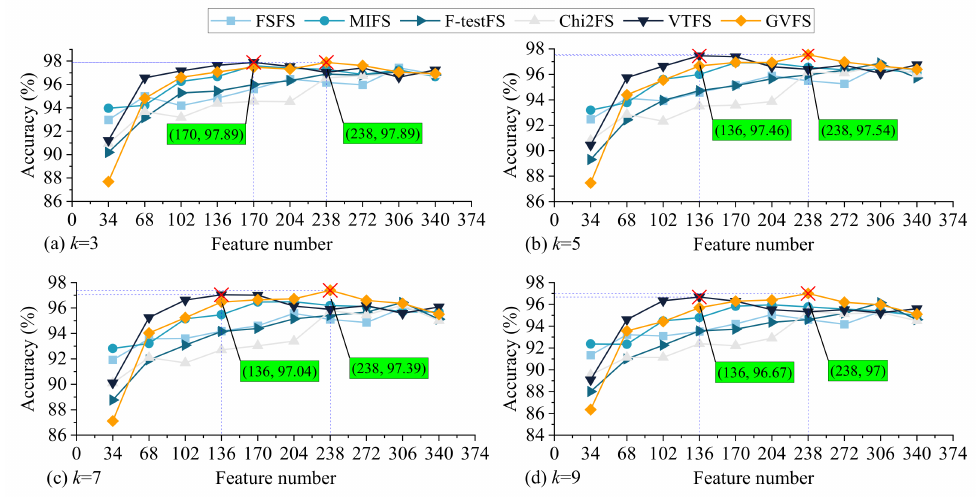
Figure 11. The fault diagnosis accuracy by utilizing the k -NN classifier with different k